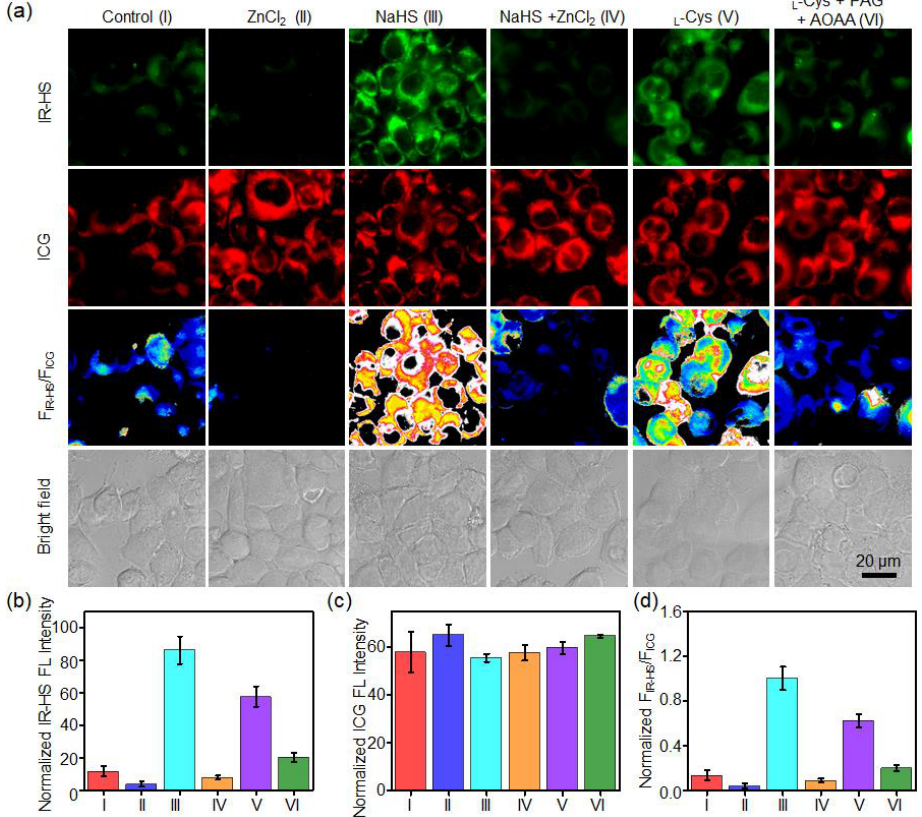
Figure 4. Ratiometric imaging of H 2 S in living HCT116 cells. ( a ) Fluorescence and ratiometric images, intensities of IR-HS ( b ) and ICG ( c ) of HCT116 cells incubated with HS-CG and the indicated reagents. Cells were untreated (Control) or pretreated with ZnCl 2 (300 μM, 10 min), NaHS (1 mM, 1 h), ZnCl 2 (300 μM, 10 min), plus NaHS (1 mM, 1 h), L - Cys (200 μM, 1 h) , or PAG (50 mg/L, 0.5 h) + AOAA (20 μΜ, 0.5 h) + L - Cys (200 μM , 1 h), and incubated with HS- CG (4/4 μM IR -HS/ICG) for 3 h. ( d ) The fluorescence ratio (F IR-HS /F ICG ) of the HCT116 cells after treatment with the indicated conditions in ( a ). Values are the mean ± s.d. ( n = 3).